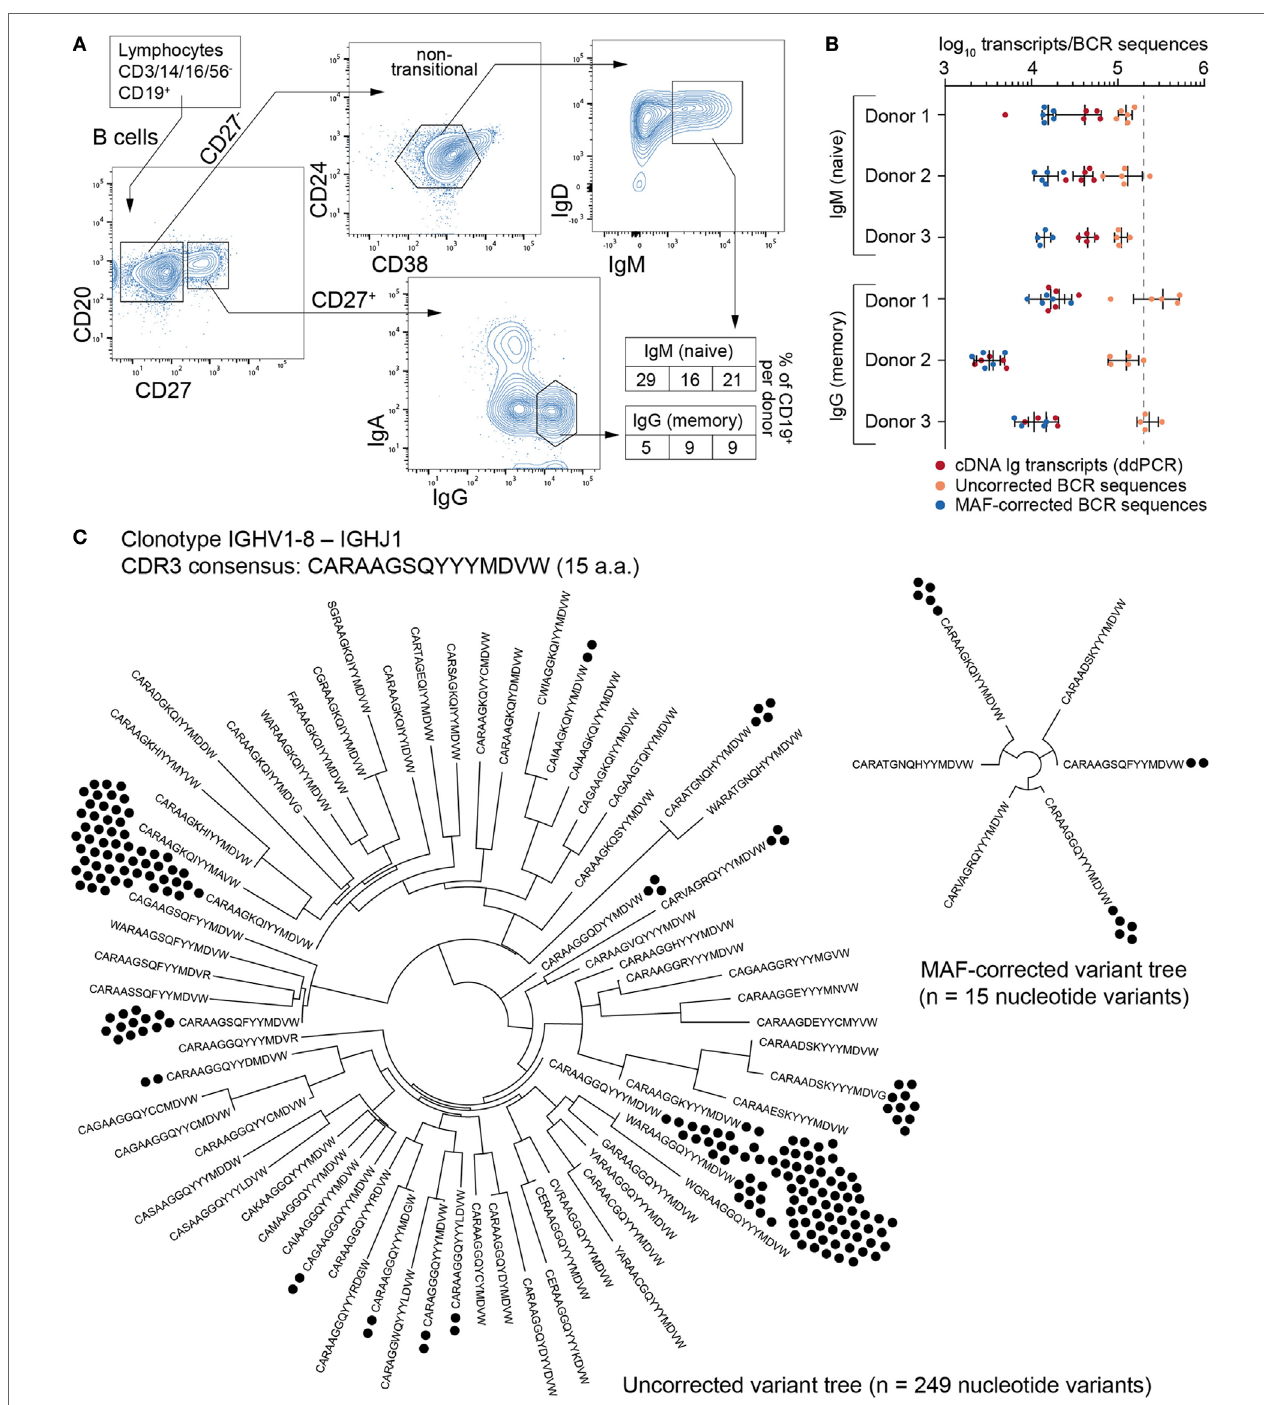
FIgURe 4 | Ig-seq analysis of human naïve (CD27 − IgM + ) and memory (CD27 + IgG + ) B cells. (A) The flow cytometric workflow for isolating CD27 − IgM + and CD27 + IgG + B cells from peripheral blood. Boxed-in values indicate the frequency of each sorted subset as a percentage of the total B cell (CD19 + ) population from each of three donors (1–3 from left to right). (B) Experimental and Ig-seq based quantitation of antibody diversity; points represent cDNA molecule counts [using digital droplet PCR (ddPCR)] or unique reads [before and after molecular amplification fingerprinting (MAF) error correction] from cellular replicates (with mean and standard deviation shown) isolated from each donor and B cell subset. Unique read counts were based on the VDJ nt seqeunce. Dashed line represents the number of B cells isolated per cellular replicate (2 × 10 5 cells). (c) Phylogenetic trees illustrating complementarity determining region 3 (CDR3) a.a. and nt variants present for the selected clonotype with the consensus CDR3 sequence CARAAGSQYYYMDVW and IGHV1-8 to IGHJ1 recombination. Prior to error correction, 70 erroneous CDR3 a.a. variants and 249 VDJ nt variants (black circles) were observed. Following MAF error correction, only 6 CDR3 a.a. and 15 VDJ nt variants remain. The Ig-seq data sets used in (B) are described in Table S3 in Supplementary Material; IgG1_D1 was used for the tree in panel (c)